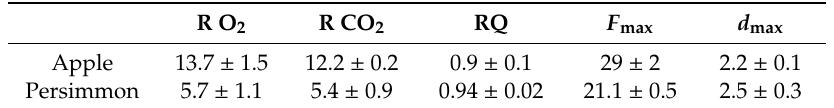
Table 3. Respiration rates (consumption of O 2 and production of CO 2 , mL · kg − 1 · h − 1 ), respiration quotient (RQ), and maximum puncture force ( F max , N) and penetration distance ( d max , mm) of uncoated ‘Golden Delicious’ apples and ‘Rojo Brillante’ persimmons at initial time. Mean values and standard deviations.